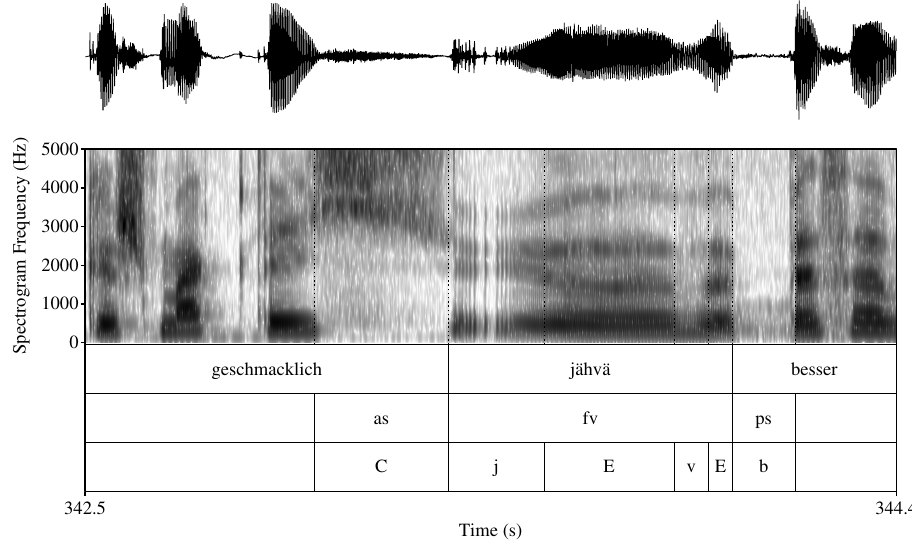
E:v@] (674 ms) between two segments ˜